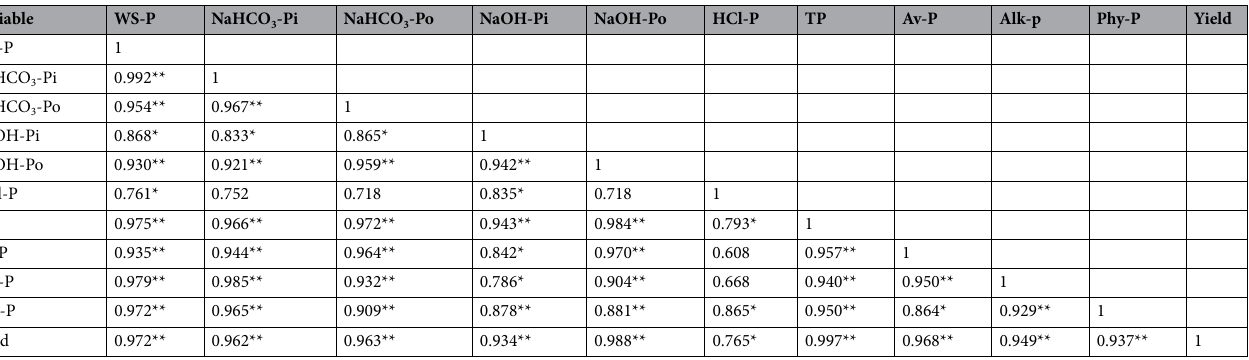
Table 4. Pearson’s correlation coefficients (r) between phosphorus fractions, biological activity and crop yield. *, **Significant at 0.05 and 0.01 probability level, respectively. WS-P Water soluble phosphorus, NaHCO 3 -P i Sodium bicarbonate inorganic phosphorus, NaHCO 3 -P o Sodium bicarbonate organic phosphorus, NaOH- P i Sodium hydroxide inorganic phosphorus, NaOH-P o Sodium hydroxide organic phosphorus, HCl-P Hydrochloride phosphorus, TP Total Phosphorus, Av-P Available phosphorus, Alk-P Alkaline phosphatase activity, Phy-P Phytin-P.